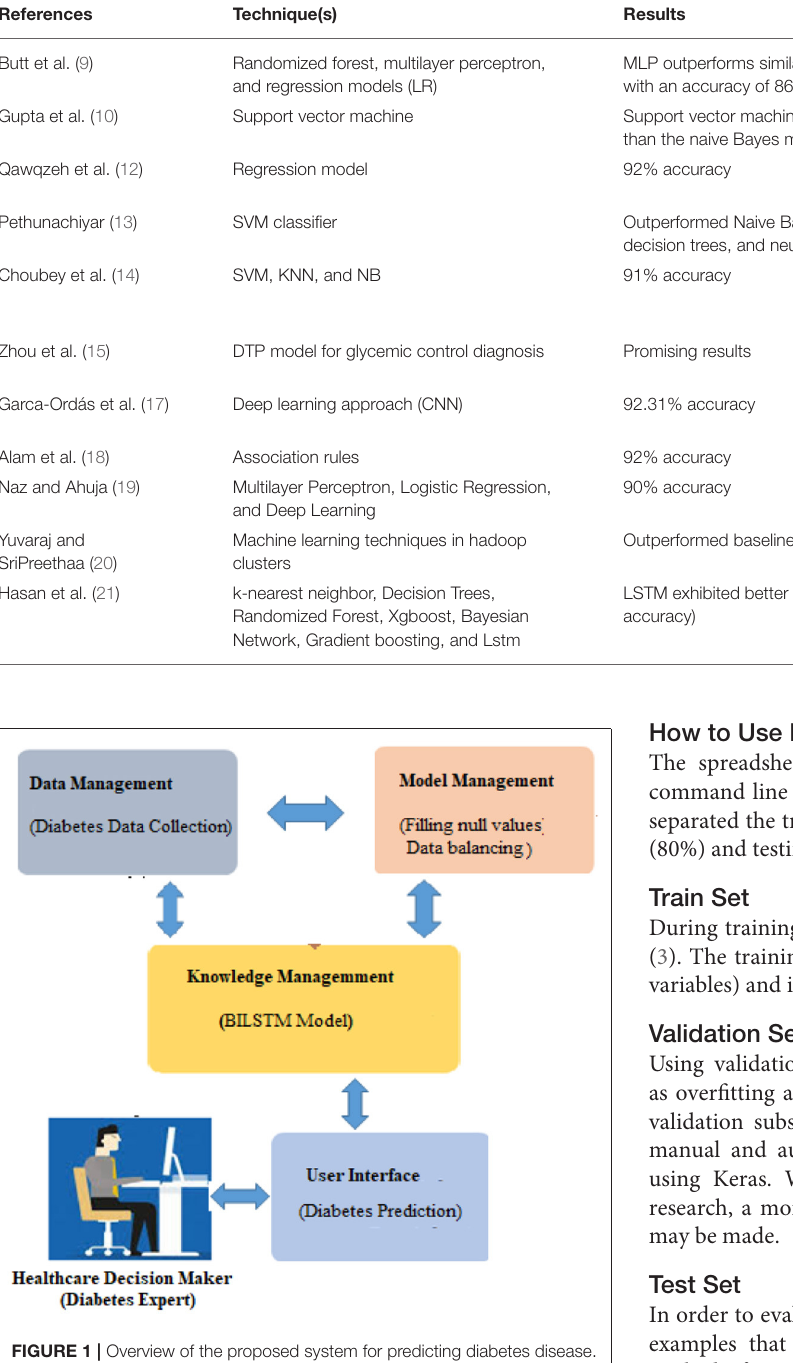
ancestry who were over the age of 20 at the time of data collection and who resided in the United States. The output data parameter accepts either a value of 0 or 1, with value 1 indicating a positive diabetic test and “0” indicating a negative diabetic diagnostic. An overview of the eight diagnostic attributes and their descriptions is provided in Figure 2